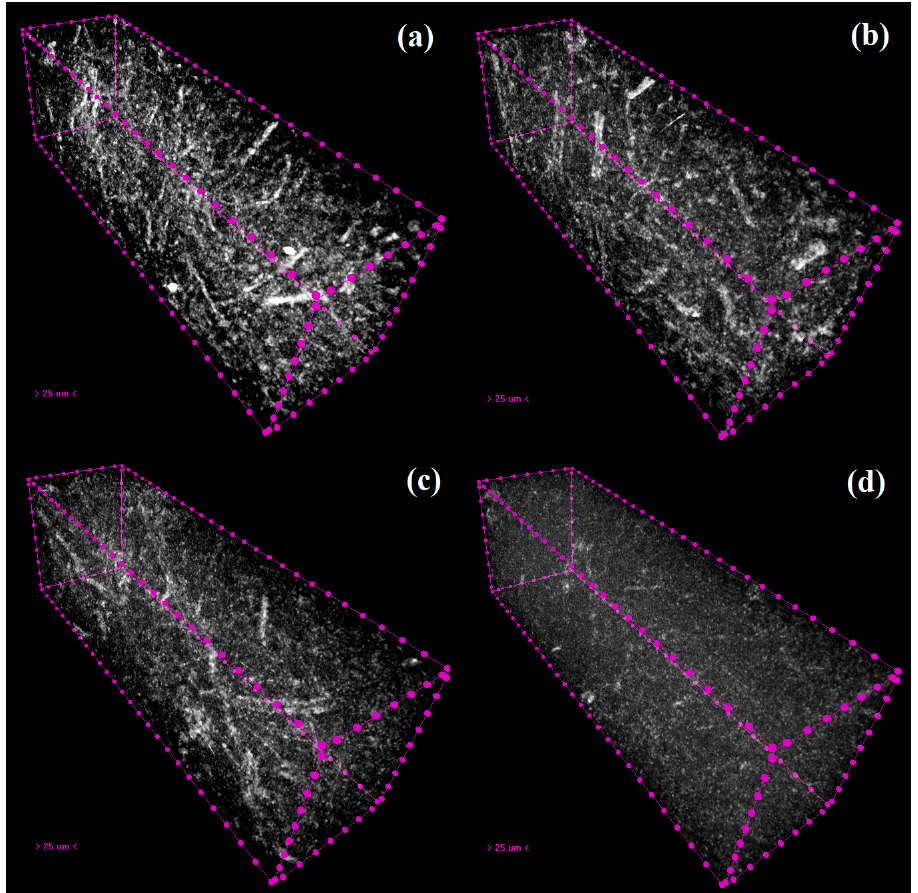
Figure 8. X-ray computed tomography of nanocomposites with 50 wt % reinforcing phase with varying chitin nanofiber (ChNF) to microfibrillated cellulose (MFC) ratios: ( a ) 4:1; ( b ) 1:1; ( c ) 1:4; ( d ) 0:1 (all MFC-reinforced). Due to the resolution limitation, the ChNF comprised of sub-micrometer diameter elements is not observable, whereas the portion of MFC larger than a few micrometers is seen as white